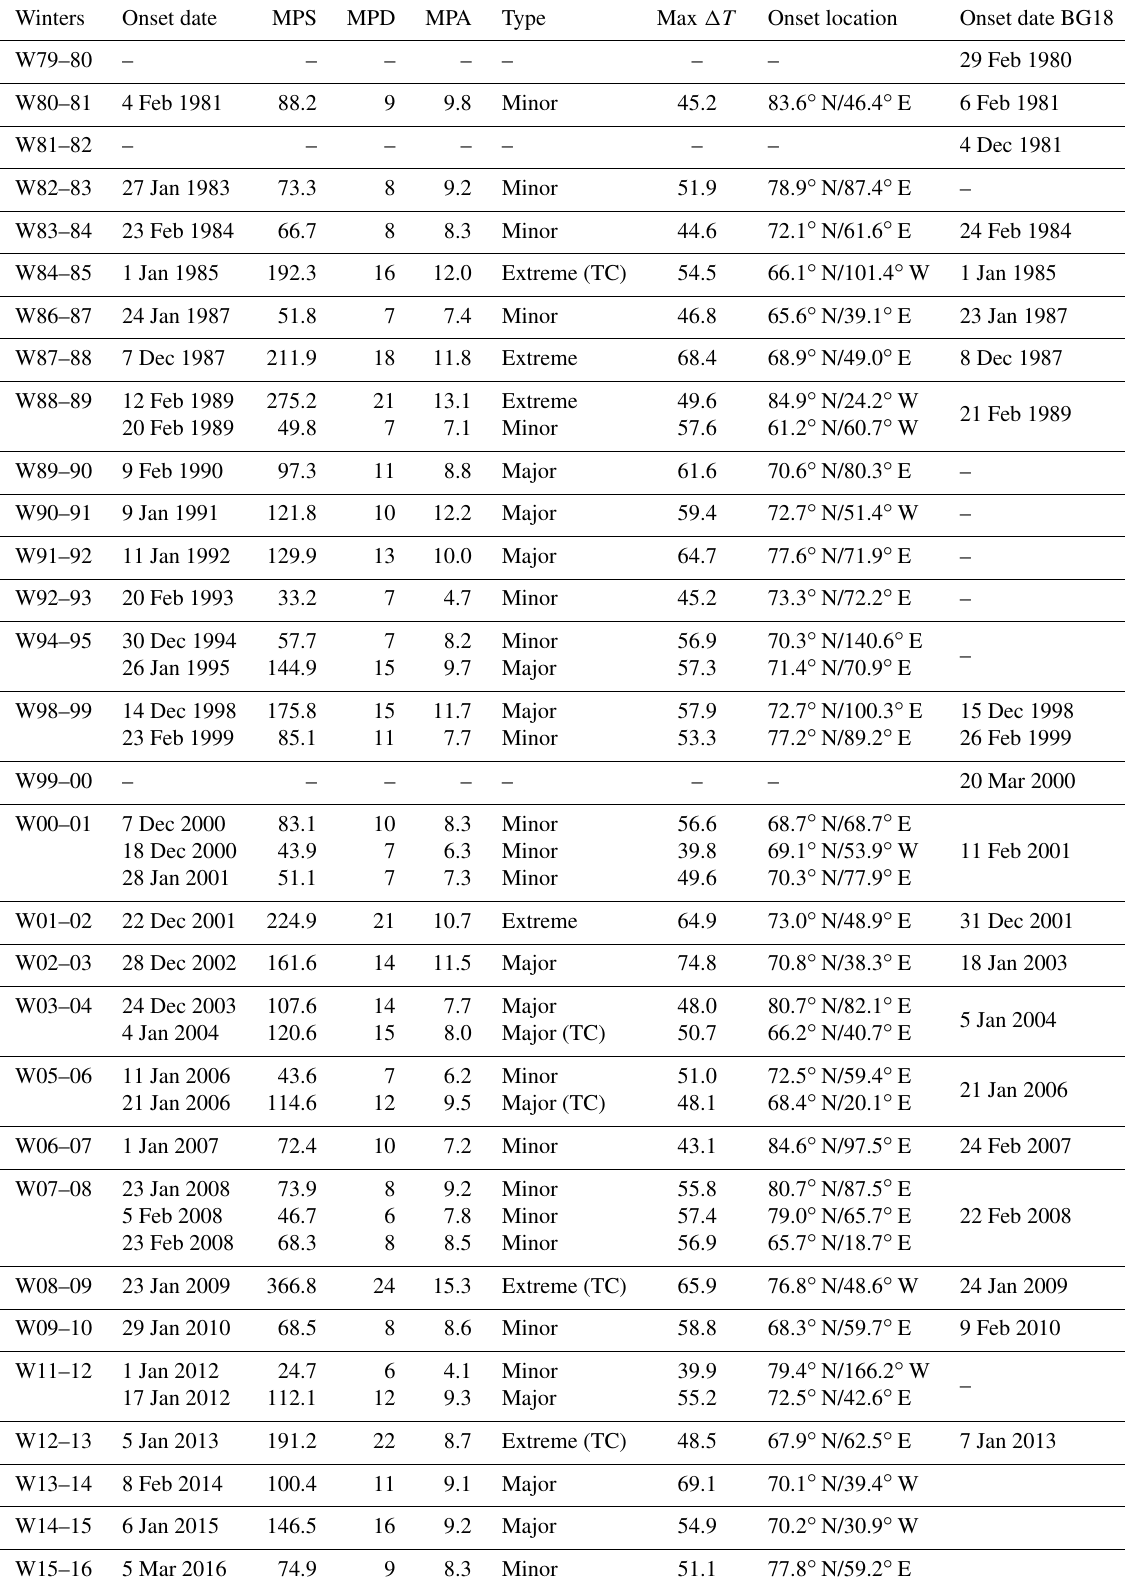
Table 3. SSW climatology summary for 1979–2021 based on ERA5 (for definition and units of all parameters, see Table 2; winters where no events are detected by either the new method or the BG18 study are skipped in this